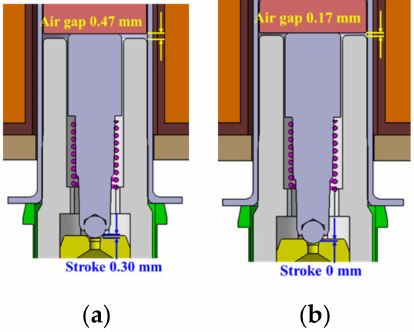
Figure 4. Air gap between the armature and magnet core: ( a ) Sol-seat flow path open; ( b ) Sol-seat flow path